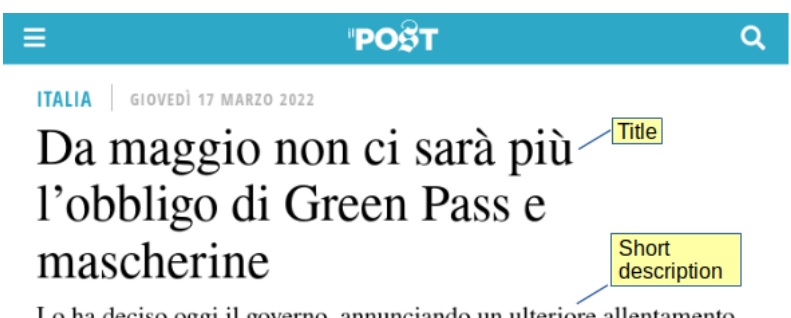
Figure 1. An example of an article downloaded from the IlPost news website. The figure highlights the title and the short description, which are usually followed by an image and the full